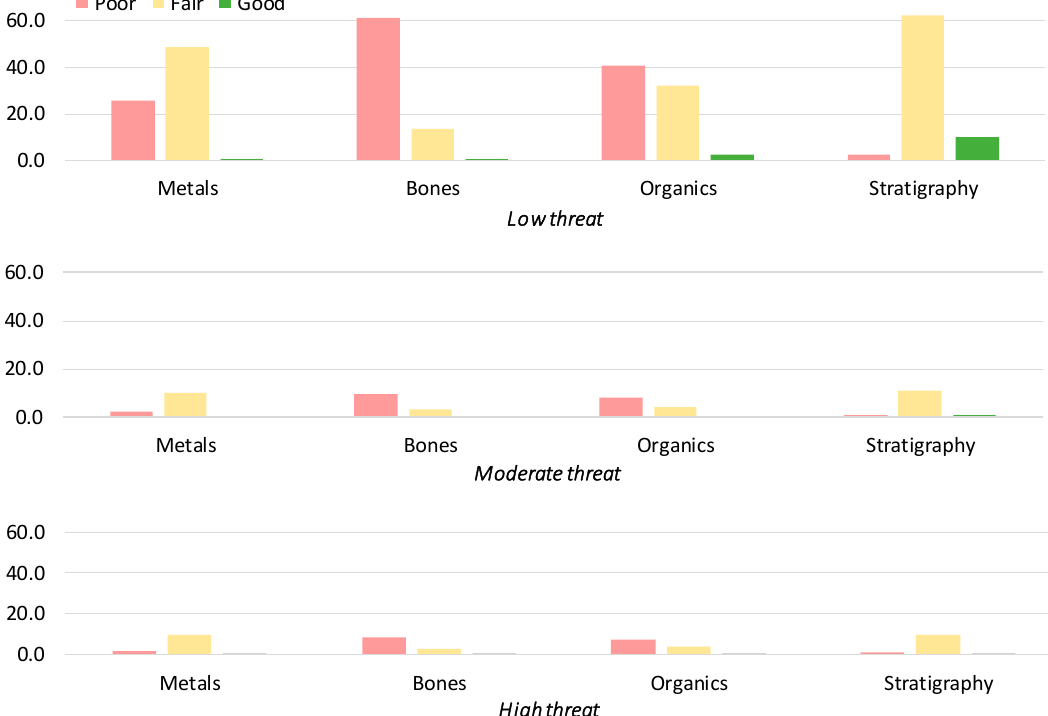
Figure 6. Quantitative analysis of the findings of Figure 4 for low (1st row), moderate (2nd row), and high (3rd row) threat from soil loss by water for the four different subsurface materials discussed in this study (metals, bones, organics, and stratigraphy evidence) and the preservation status. Table 1. Absolute areas of the subsurface materials studied here (metals, bones, organics, and